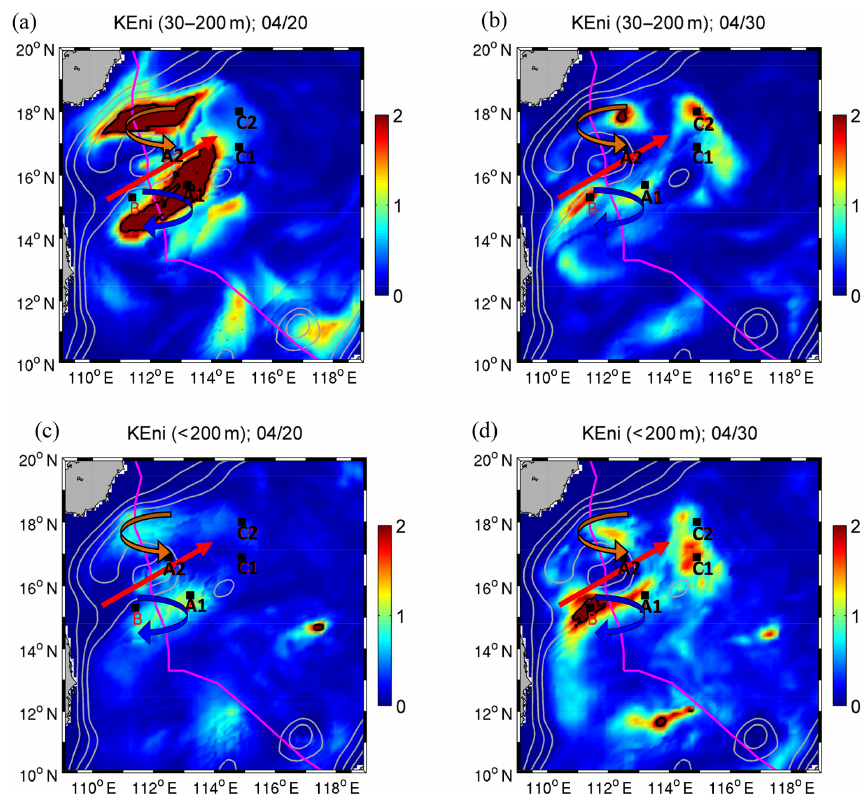
Figure 8. Daily averaged KEni (KJm − 2 ) of layers (a, b) 30–200m and (c, d) < 200m on (a, c) 20 April during FS and (b, d) 30 April during RS. The thick red arrows show the location of the jet (Fig. 2), while the blue curved arrows indicate regions with relative vorticity ζ< 0 and the orange curved arrows indicate regions with ζ> 0. Stations A1 and A2 are on the right side of the TC track at the northern (A2) and southern (A1) sides of the jet, respectively. Stations C1 and C2 are corresponding stations in the far field. Station B is located in the upstream area of the